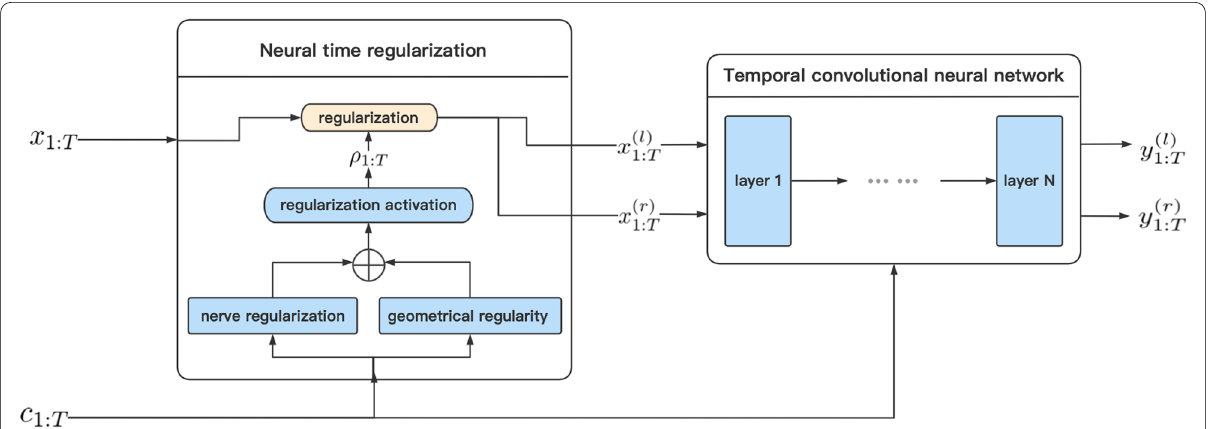
Fig. 3 End-to-end binaural audio synthesis